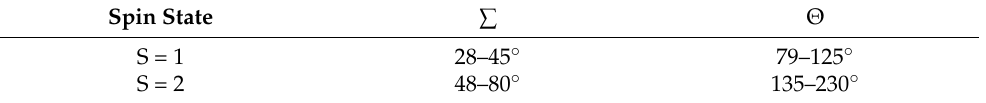
Table 2. Previously observed values for ∑ and Θ in this class of SCO compounds.